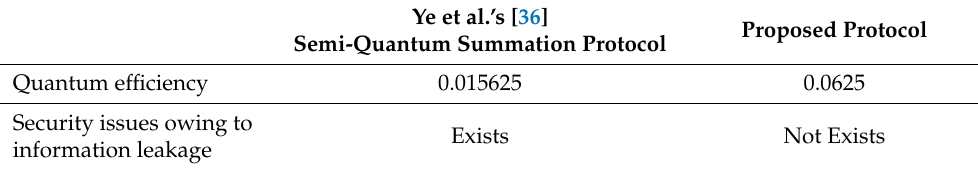
Table 2. Performance comparison of Ye et al.’s semi-quantum summation protocol and the pro- posed